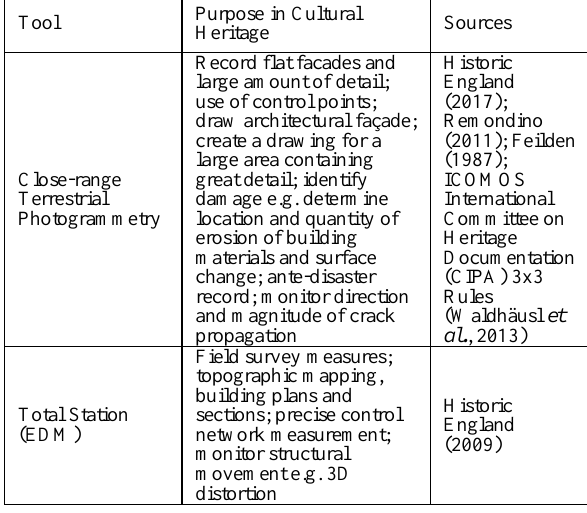
Table 1. Digital tools for recording and monitoring the condition of cultural heritage . Source: based on Vileikis (2018).